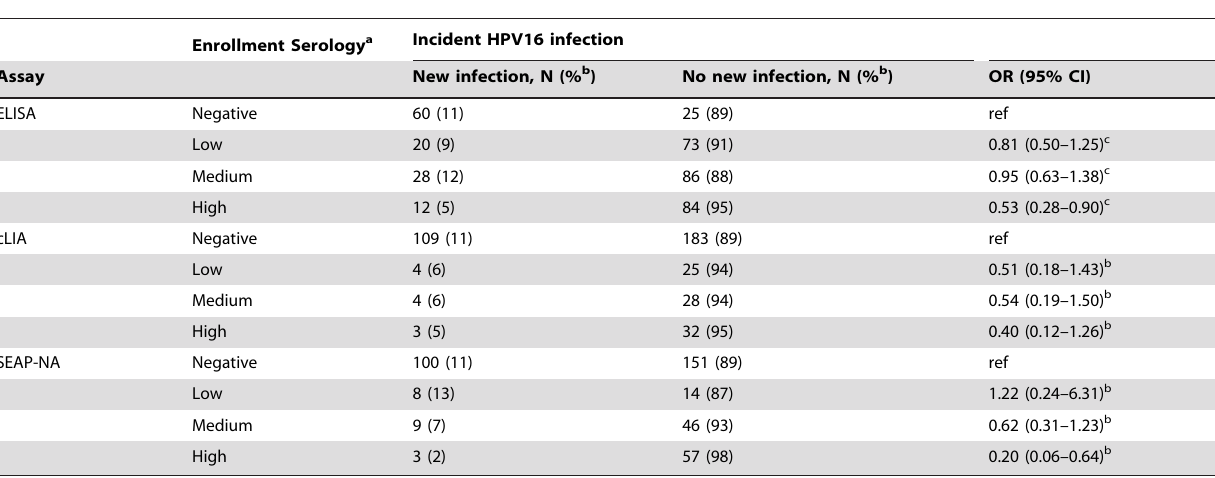
Table 3. Odds ratios and 95% confidence intervals for seropositive tertile categorizations of HPV16 assay results at baseline and risk of incident HPV16 DNA